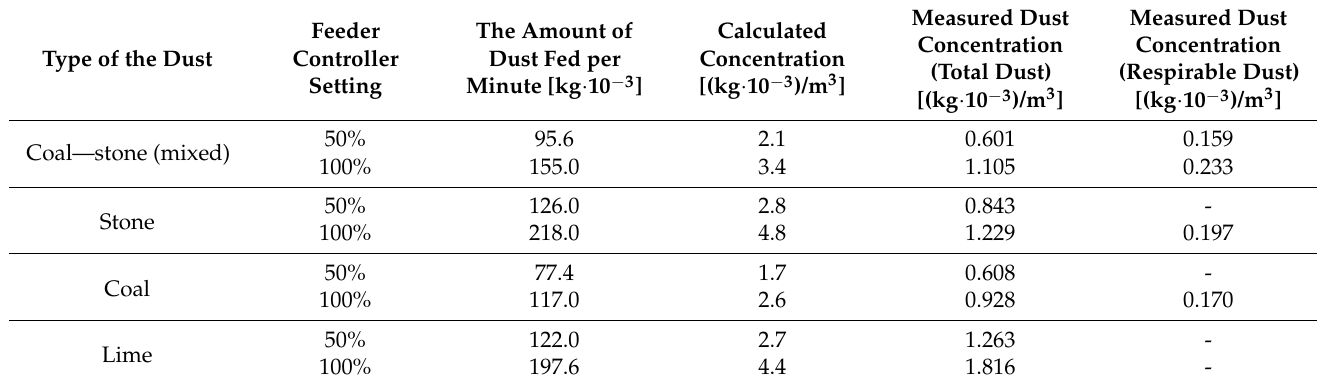
Table 1. Values of dust concentration inside the tunnel during tests with AR30